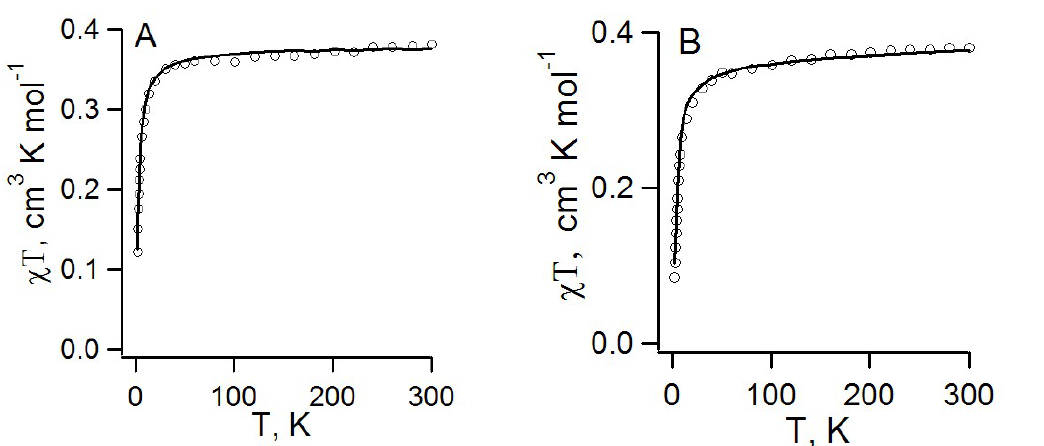
Figure 17. Experimental χ (T)T dependences (circles) and their theoretical approximation (solid curves) using Bonner-Fisher uniform chain model with J = − 1.22 cm − 1 ( A , salt 70c , r = 0.9997) and J = − 1.65 cm − 1 ( B , salt 71 , r = 0.997).